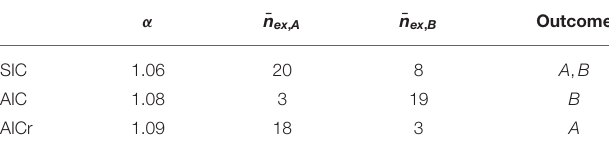
N α with the system size N . ∼